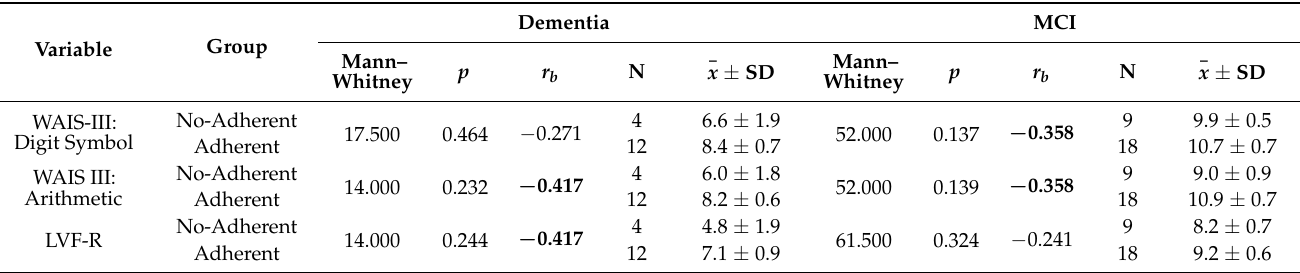
Table 5. Mann–Whitney U test. Comparison between MCI-adherent vs. MCI-non-adherent and mild dementia-adherent vs.